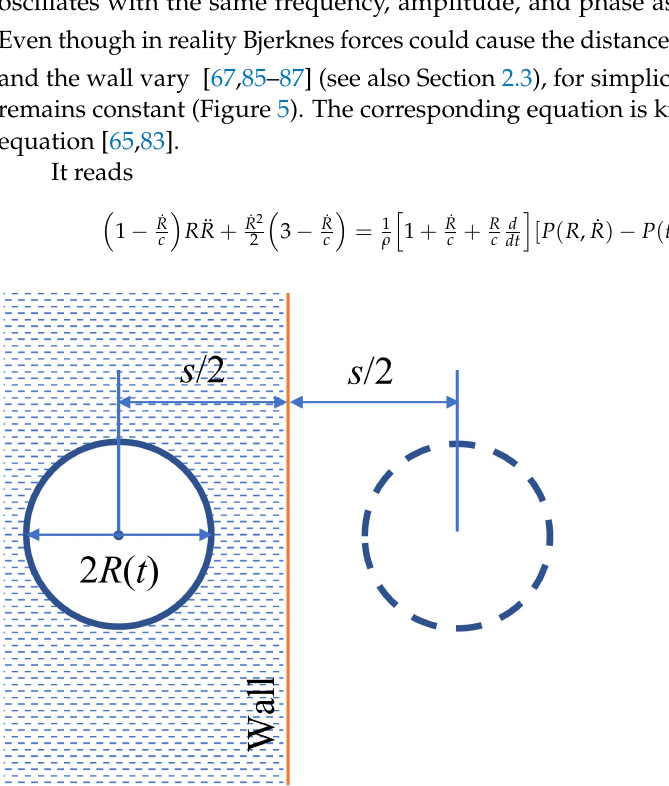
Figure 5. Schematic view of a bubble near a solid wall. The bubble on the right is the ‘mirror’ image of the real